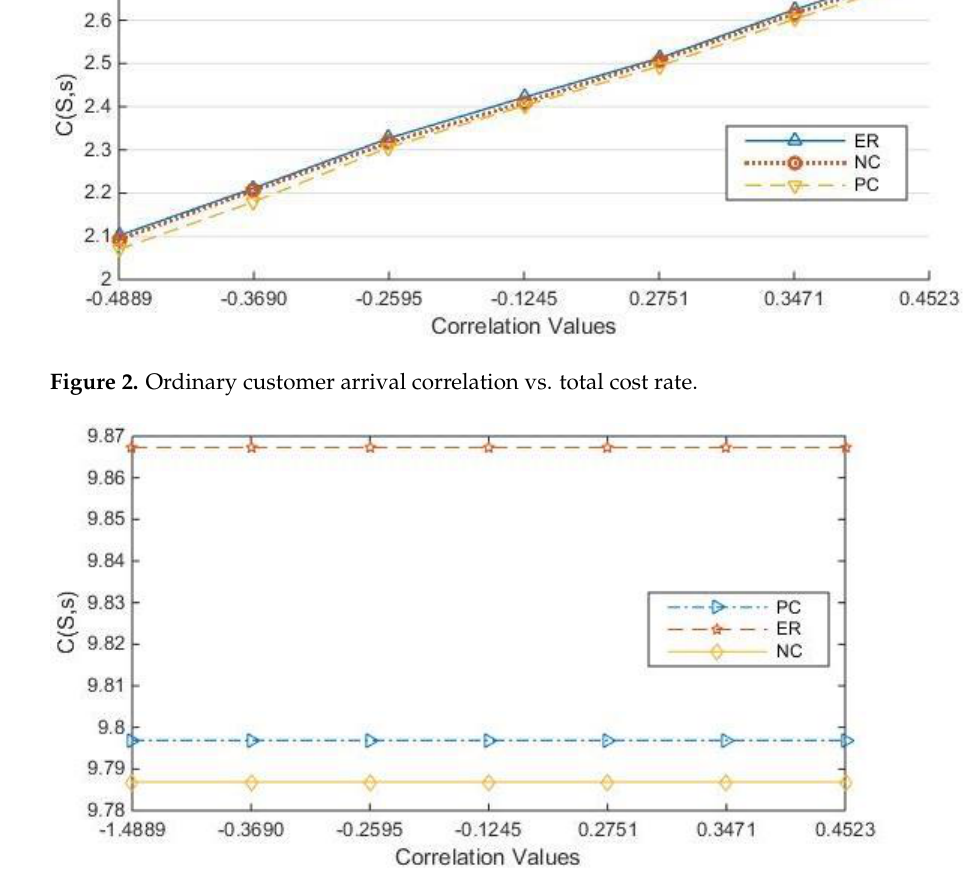
Figure 3. Impulse customer arrival correlation vs. total cost